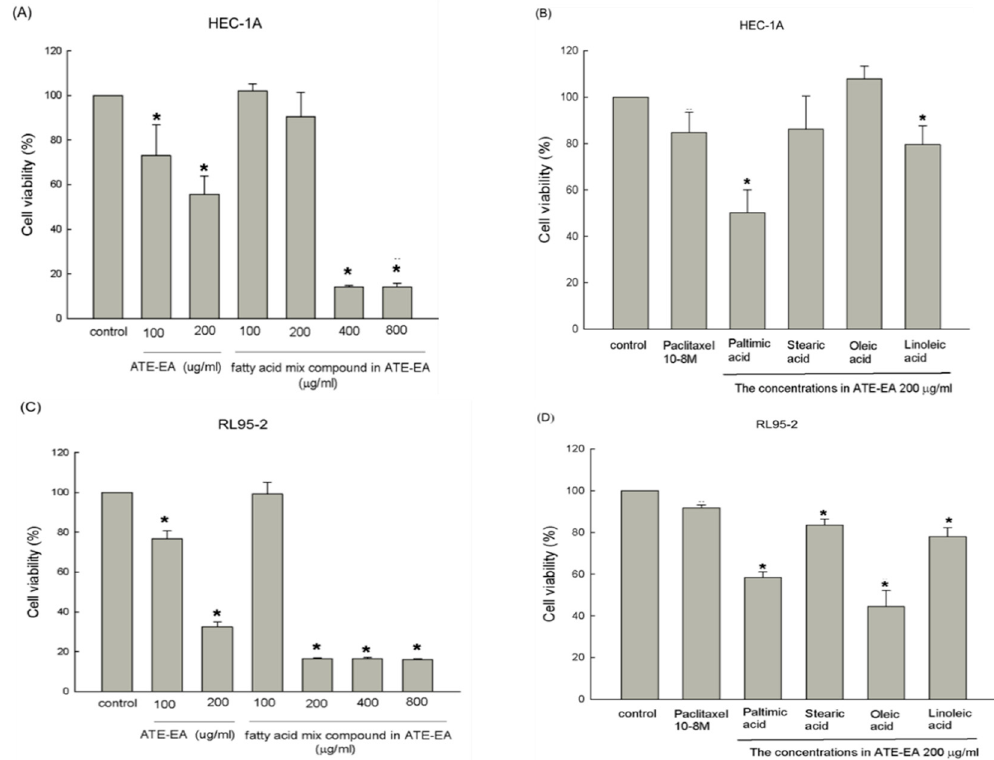
Figure 5. Effects of fatty acid compounds from ATE-EA on the viability of HEC-1A and RL95-2 cells. HEC-1A cells were treated with serial concentrations of fatty acid compounds ( A ) and its constituents at a concentration of 200 μ g/mL ( B ) of ATE-EA for 2 days. RL95-2 cells were treated with serial concentrations of fatty acid compounds ( C ) and its constituents at a concentration of 200 μ g/mL ( D ). Data are expressed as means ± SD ( n = 3). * p < 0.05, compared with the control group at the basal level. ATE-EA, ethyl acetate fraction of the adlay testa ethanolic extract.